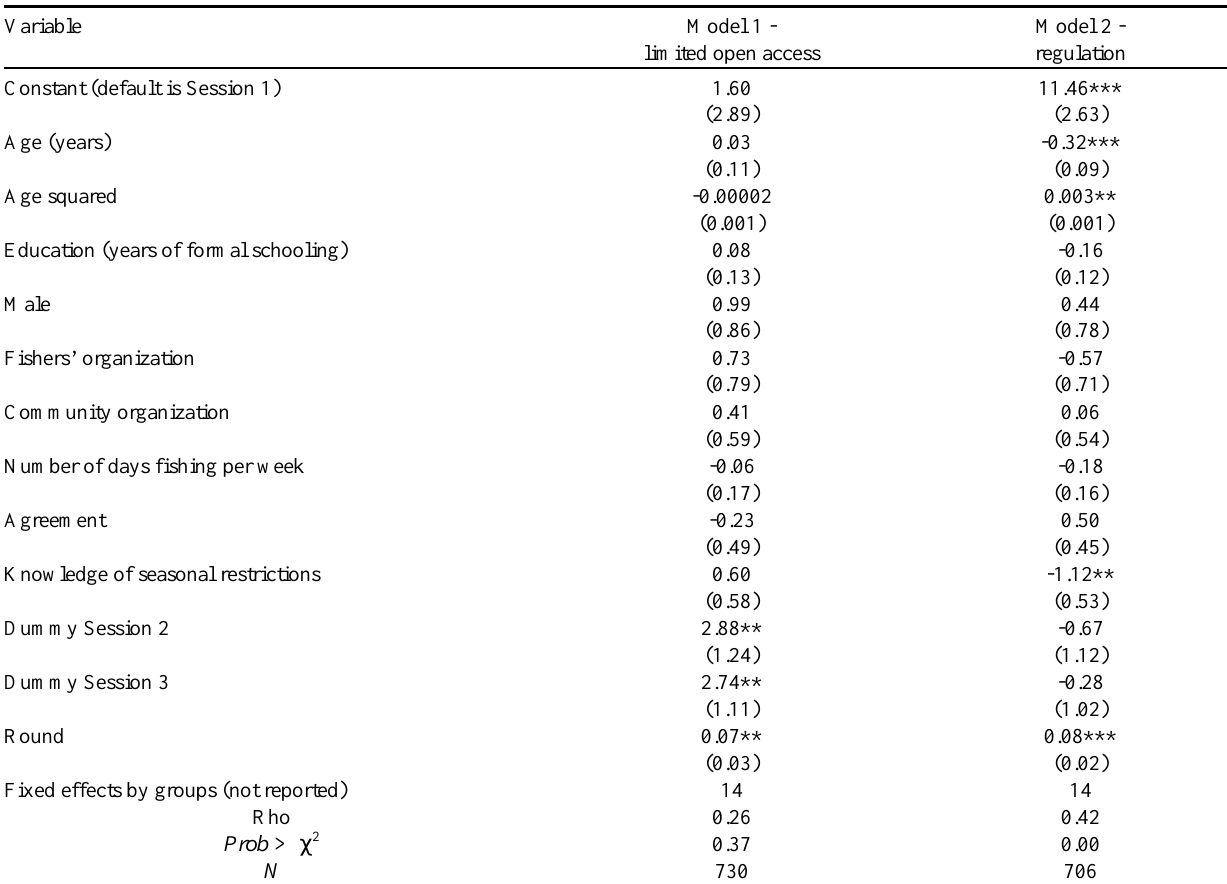
Table 5 . Random effects Tobit estimation of individual extraction (standard error in